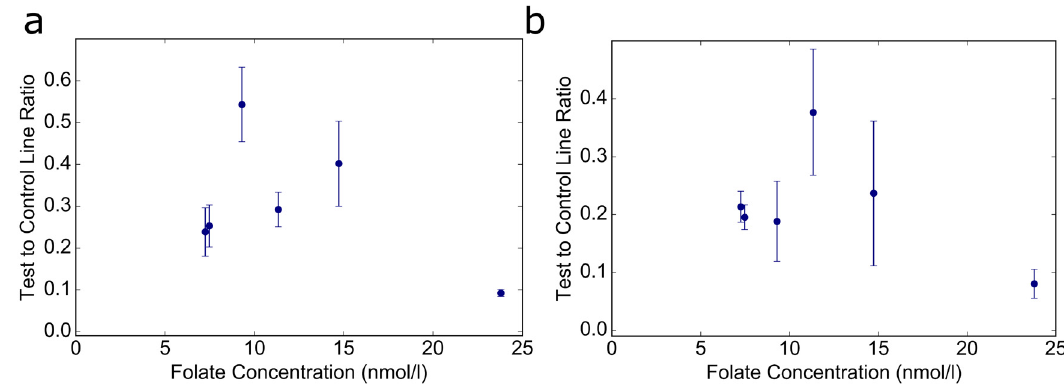
Fig 4. Serum results without heat denaturation and without washing and secondary addition of FITC conjugates. (a) Mean T/C ratio versus folate concentration for 6 serum samples tested without heating. Error bars shown are standard deviation, n = 3. (b) Mean T/C ratio versus folate concentration for 6 serum samples tested in a traditional lateral flow assay format. Error bars shown are standard deviation, n =